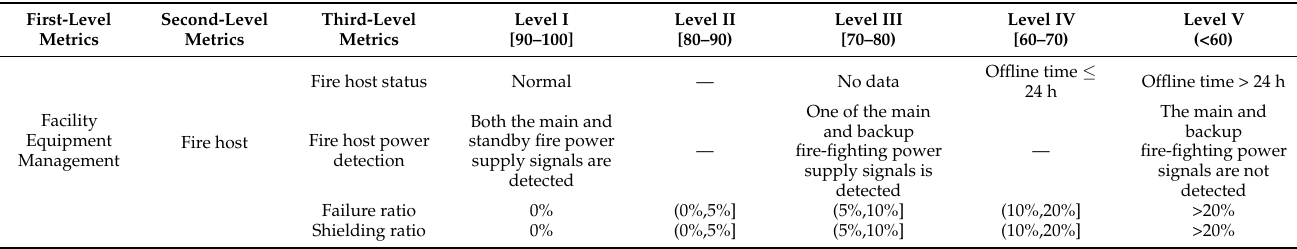
Table 3. Examples of dynamic fire risk indicators for